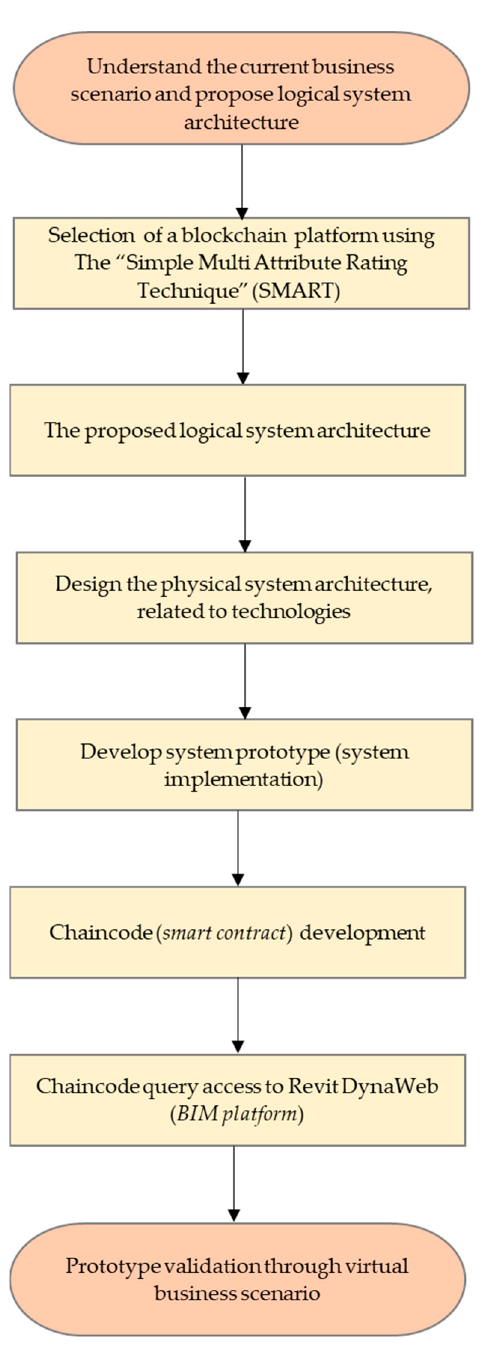
Figure 1. The development process of the BIM single source of truth prototype using blockchain technology.